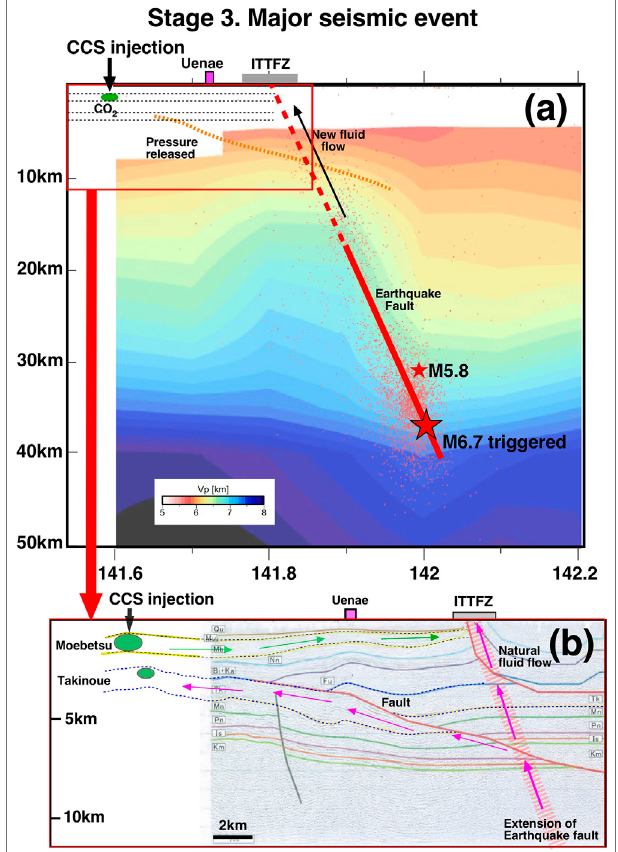
FIGURE 5 | Schematic vertical cross-section of the Hokkaido Iburi regionalong the H91-3 seismic pro fi le of Figure 1 , and its extensionsouthwest andnortheastsoonaftertheM6.7earthquake (A) P-wavevelocity(Vp)structure ofthecrustanduppermantleintheregion.Theredsolidlineanddottedline show earthquake fault and hypothetical new fl uid fl ow, respectively. The orange dotted curve denotes a fault found by seismic re fl ection survey. Distributions of small red dots are aftershocks. A large red star indicates the position of main shock (M6.7). (B) Modi fi ed subsurface structure of the seismic section along H91-3in Figure1 reportedbyYokokuraetal.(2014).Redsquareoftop fi gureis enlarged here. The red solid arrows and green arrows are direction of CO 2 fl uid movement and possible pressure